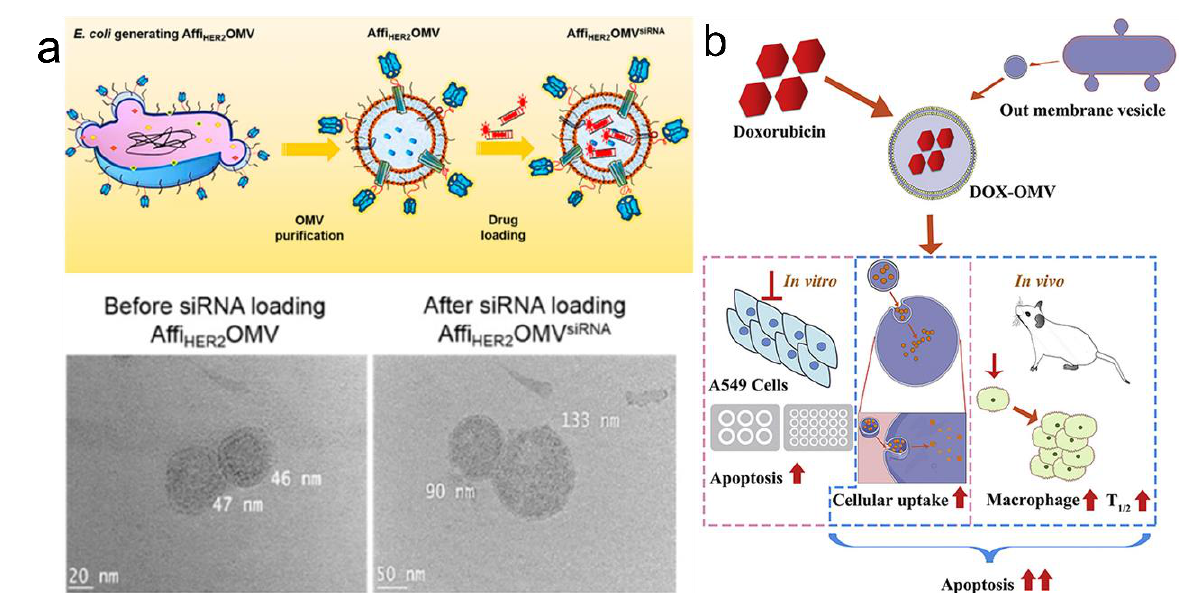
Figure 6. Drug loading in OMVs. ( a ) Loading of siRNA into Affi HER2 OMVs. Reprinted with permission from Ref. [55]. Copyright: 2014, American Chemical Society. ( b ) DOX can be loaded into OMVs via passive diffusion. Reprinted with permission from Ref. [76]. Copyright: 2020, Elsevier.